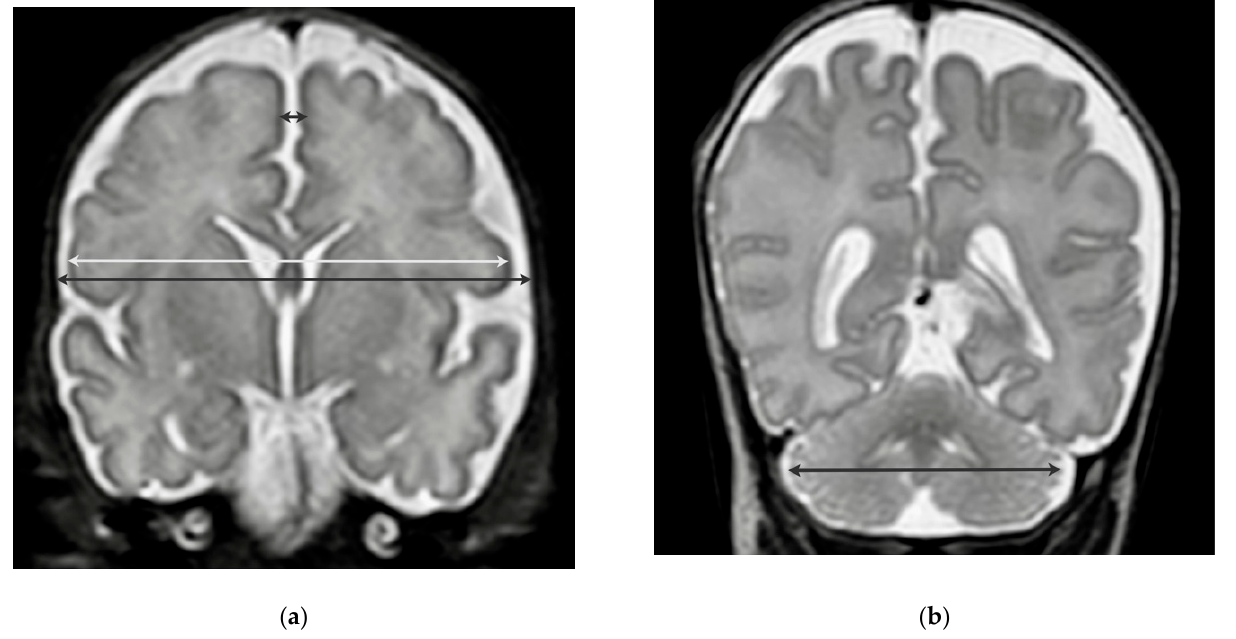
Figure 1. Measurements of ( a ) cerebral biparietal diameter (cBPD, light grey), bone biparietal diameter (bBPD, dark grey), interhemispheric distance (IHD, black) and ( b ) transverse cerebellar diameter (tCD, black).